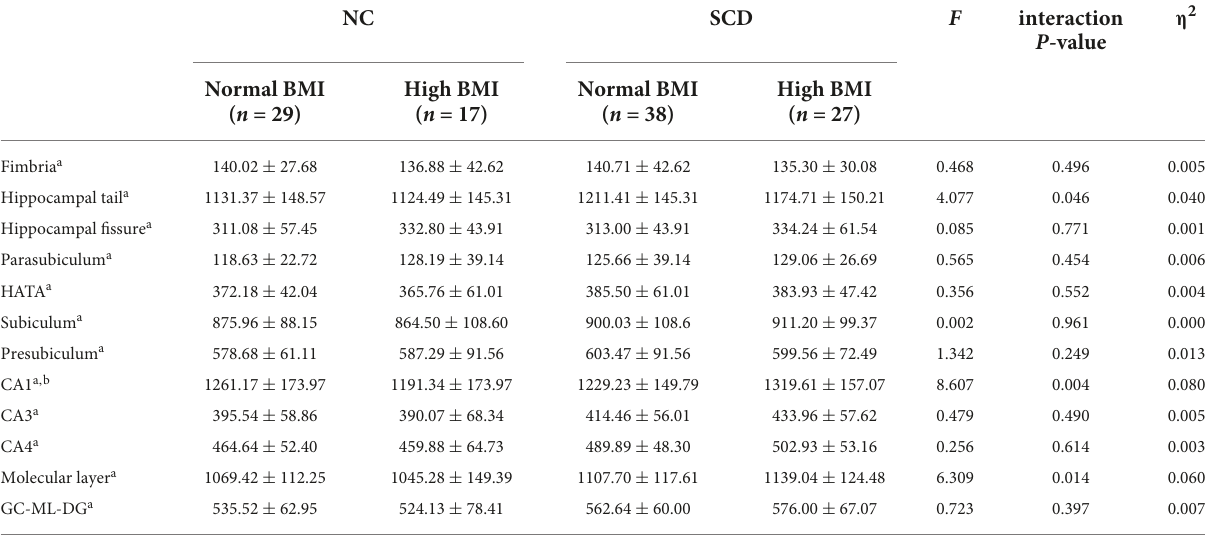
TABLE 4 Comparison of the gray matter volume of hippocampal